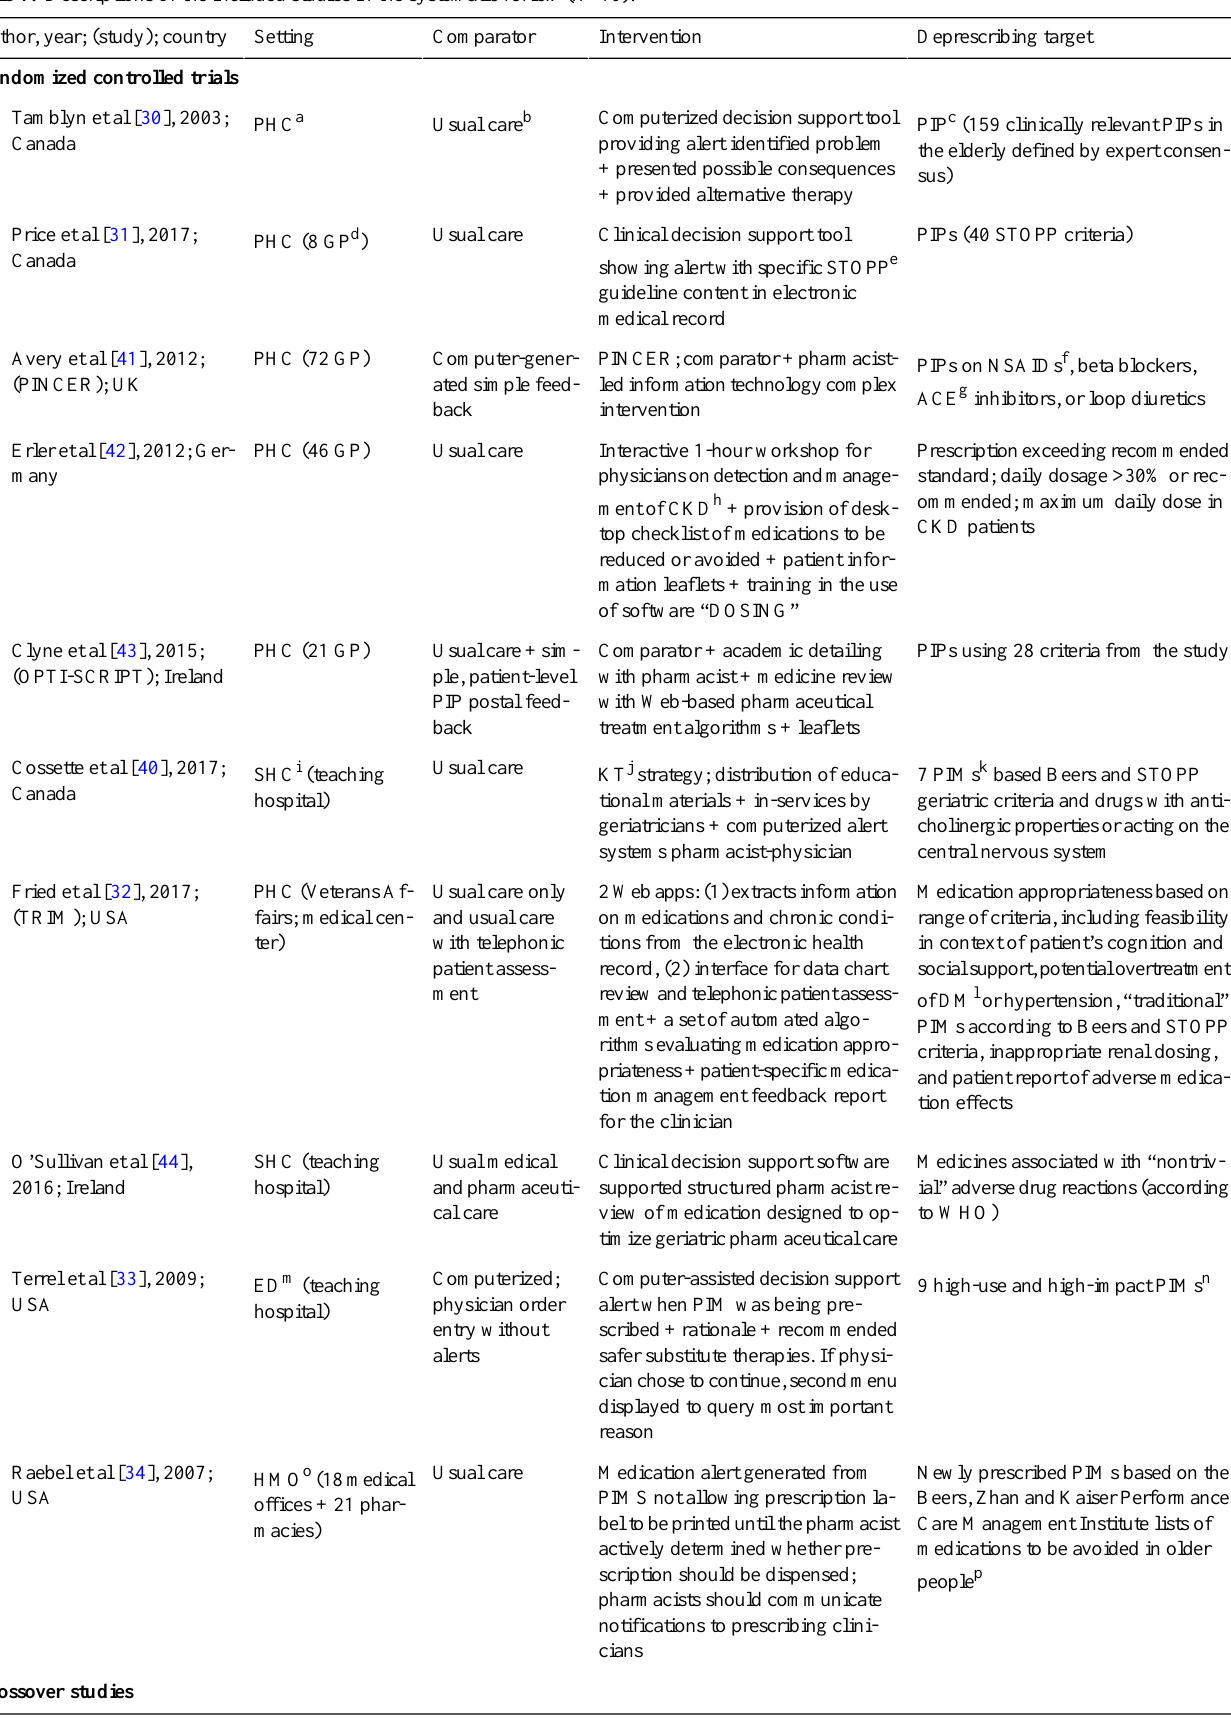
Table 1. Descriptions of the included studies in the systematic review